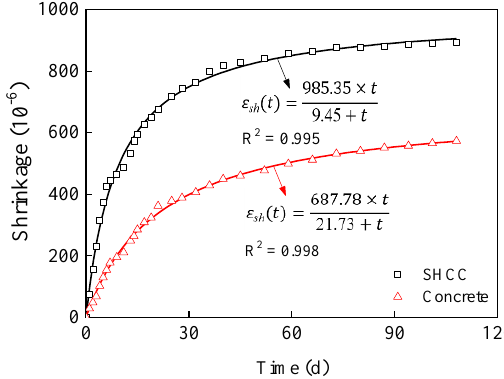
Figure 9. Drying shrinkage of SHCC and concrete.